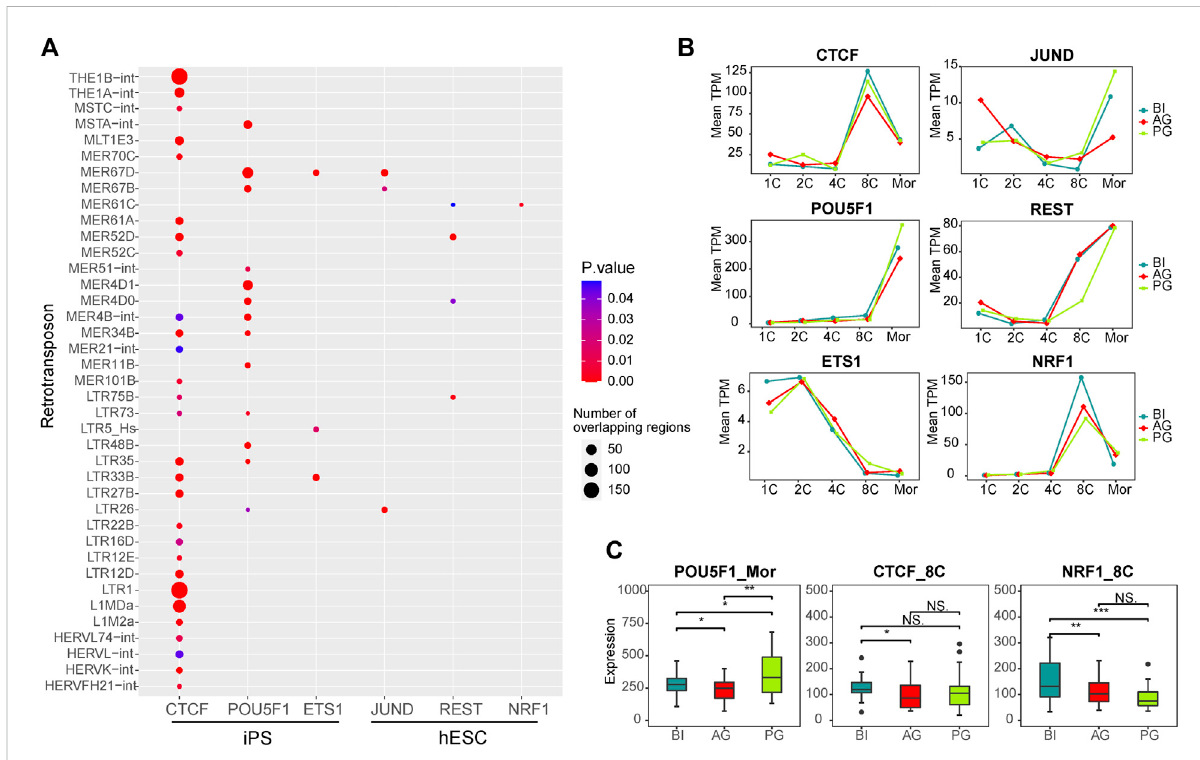
FIGURE 4 Transcription factors associated with differential transposons. (A) Dot plot showing the correlation between transcription factors which expressedinourdataanddifferentialtransposonsbetweenthreetypesofembryos.ThedotsizerepresentsthetotalnumberofTEthatintersectwith the binding sites of TF in the ChIP-seq experiment. (B) Line chart showing the expression of six transcription factors in each stage of three types of embryos. (C) The box plot shows the signi fi cant difference in the expression of POU5F1, CTCF, and NRF1 in the three embryos at the corresponding stage. Signi fi cance was calculated using the t